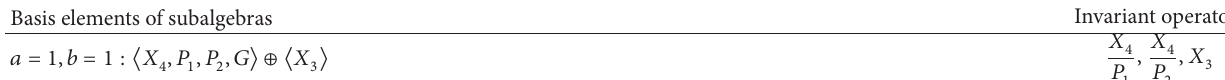
Table 12: Invariant operators of subalgebra of the type 𝐴 𝑎𝑏 4,5 ⊕ 𝐴 1